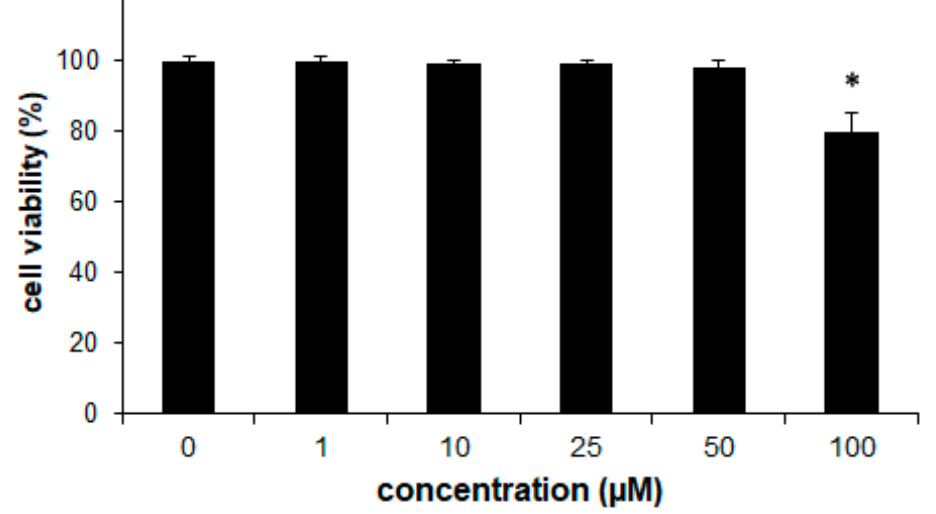
Figure 10. The effects of 2-chloro-3-hydrazinopyrazine toward HaCaT cells. The viability of HaCaT cells was determined with the MTT assay after 72 h. Values represent mean ± SE of three independent experiments. p < 0.05 (*) indicates differences between control and treated cells.